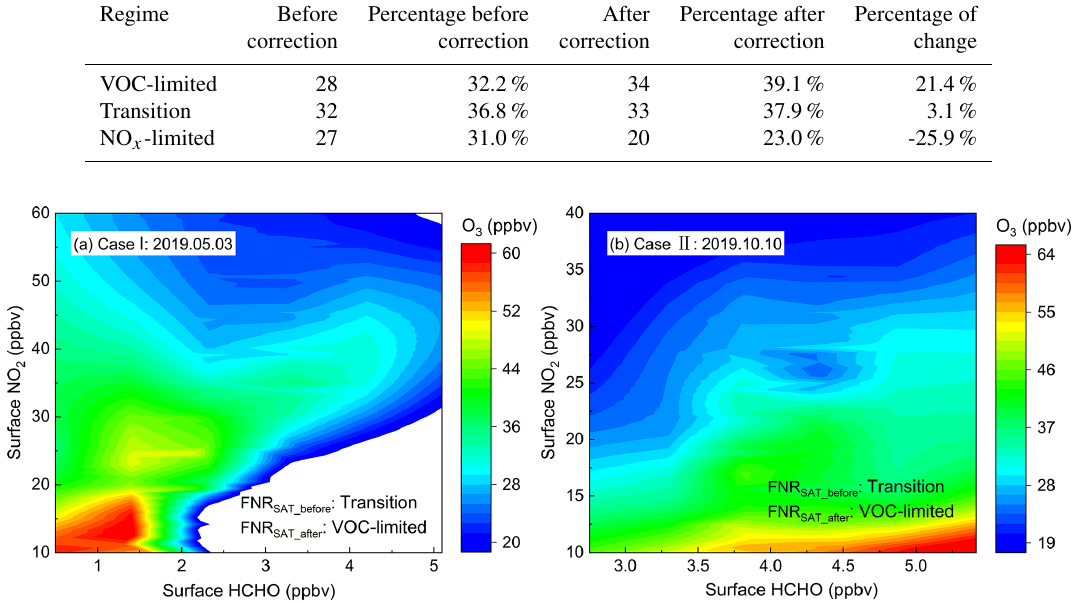
Figure 11. The variation of O 3 with surface HCHO and NO 2 for two cases of (a) 3 May 2019 and (b) 10 October 2019. FNR SAT_before and FNR SAT_after indicate the O 3 formation regimes inferred from the satellite FNR before and after the correction.